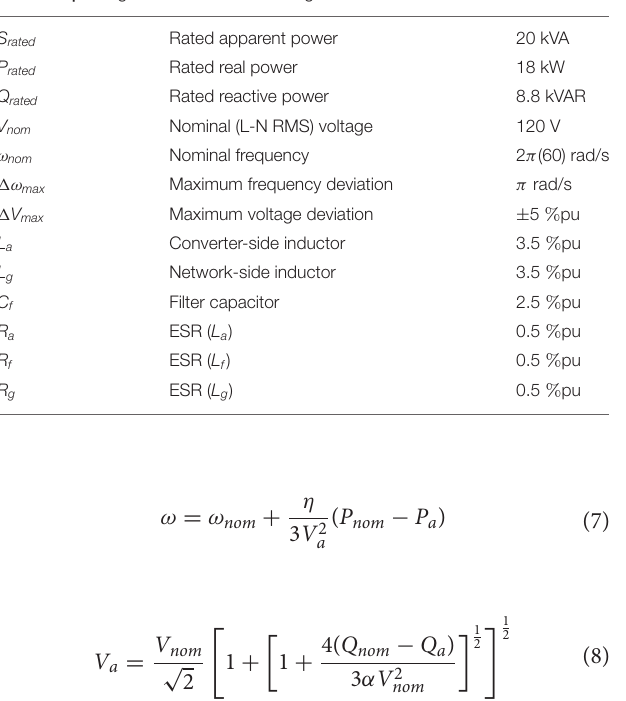
TABLE 1 | Voltage source converter